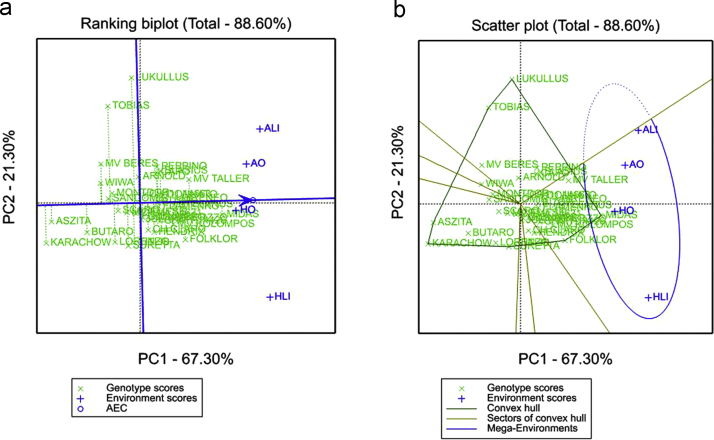
Ranking plot (a) and ‘which-won-where’ and (b) view of the GGE biplot for grain yield.